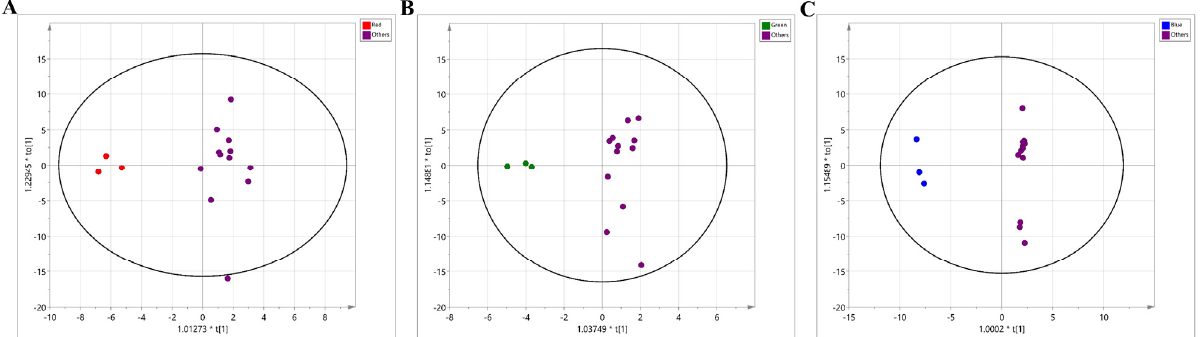
Figure 4. Multivariate statistical analysis of metabolic profiles of LED-irradiated kimchi broths. Orthogonal projection to latent structures-discriminant analysis (OPLS-DA) for pair-wise comparison between red-LED groups vs. other groups (R2Y = 0.930, Q2 = 0.445) ( A ), green-LED groups vs. other groups (R2Y = 0.925, Q2 = 0.368) ( B ), and blue-LED groups vs. other groups (R2Y = 0.997, Q2 = 0.896) ( C ).